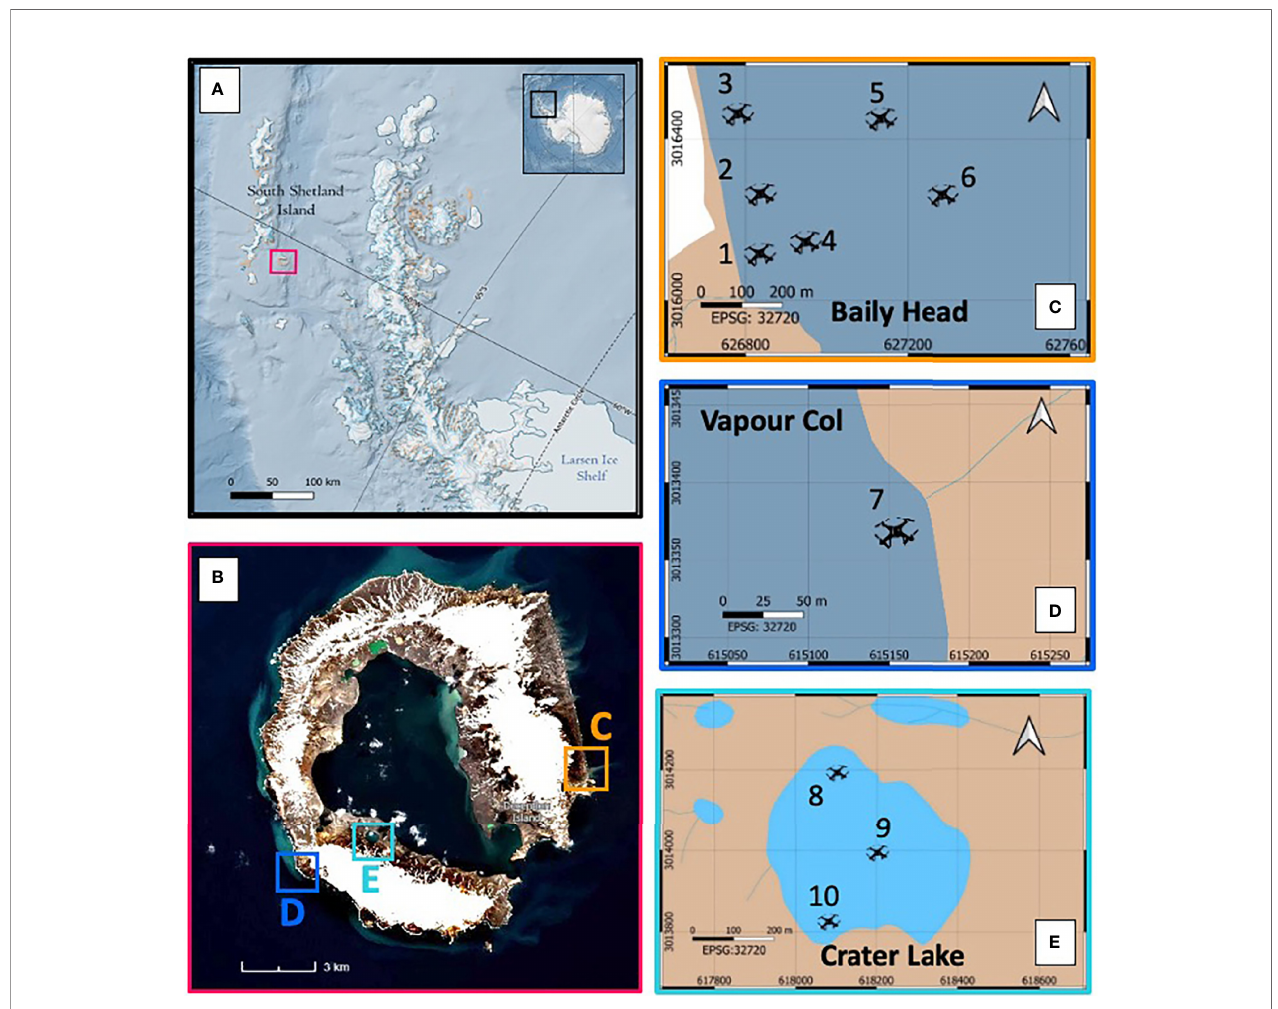
FIGURE 2 | (A, B) Location of Deception Island in the South Shetland Islands. Sampling stations at: (C) Baily Head rockery, (D) Vapour Col and (E) Crater Lake.